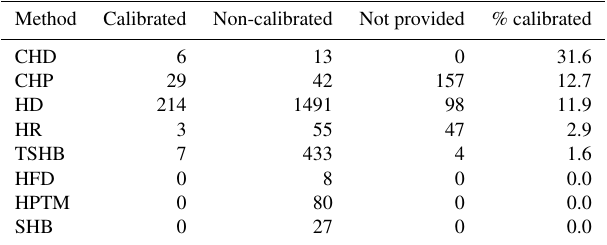
Figure 4. Distribution of plants in SAPFLUXNET according to major taxonomic group (angiosperms, gymnosperms), sap flow method (CHD: cycling heat dissipation; CHP: compensation heat pulse; HD: heat dissipation; HFD: heat field deformation: HPTM: heat pulse T-max (HPTM): HRM: heat ratio (HR); SHB: stem heat balance; TSHB: trunk sector heat balance), and reference unit for the expression of sap flow (plant, sapwood area, leaf area). Com- binations of reference units imply that data are present in multiple units. Table 1. Number of sap flow times series in SAPFLUXNET de- pending on whether they were calibrated (species-specific) or non- calibrated, or whether this information was not provided, for the different sap flow methods: cyclic (or transient) heat dissipation (CHD), compensation heat pulse (CHP), heat dissipation (HD), heat field deformation (HFD), heat pulse T-max (HPTM), heat ra- tio (HR), stem heat balance (SHB), and trunk sector heat balance (TSHB). The percentage of calibrated time series was expressed with respect to the total number of sap flow time series for each